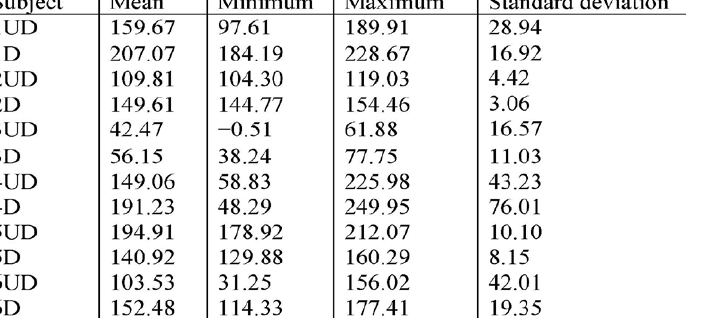
Table 1: The mean B